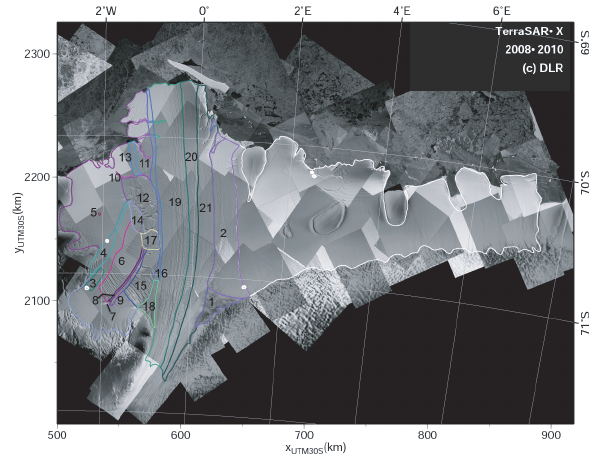
Fig. 5. TerraSAR-X mosaic and the sub domains defined from structural mapping of TerraSAR-X images and the RES classifica-